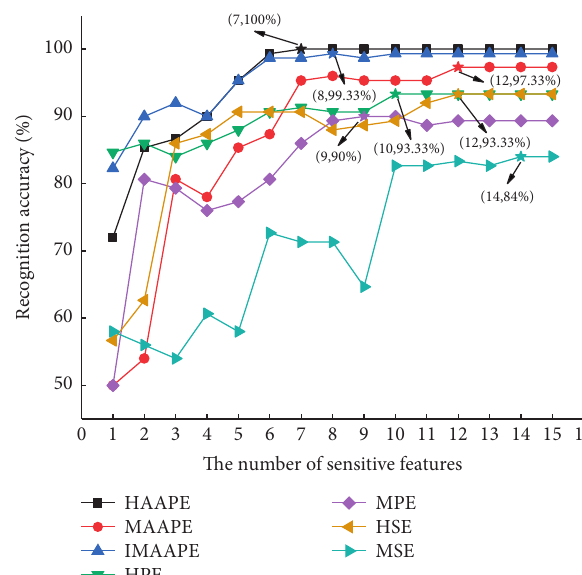
Figure 15: The relationship between the number of features and the recognition